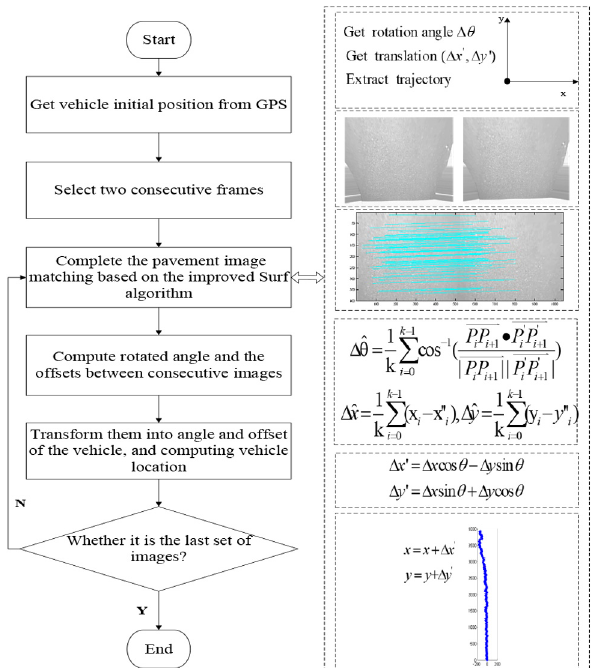
Figure 2 The overall fl ow chart of the